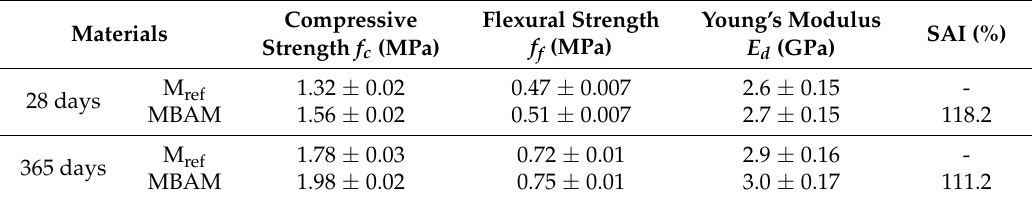
Table 6. Mechanical properties.